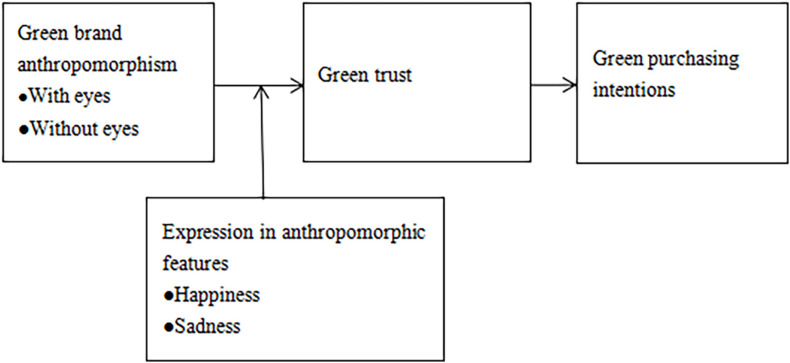
Research framework.